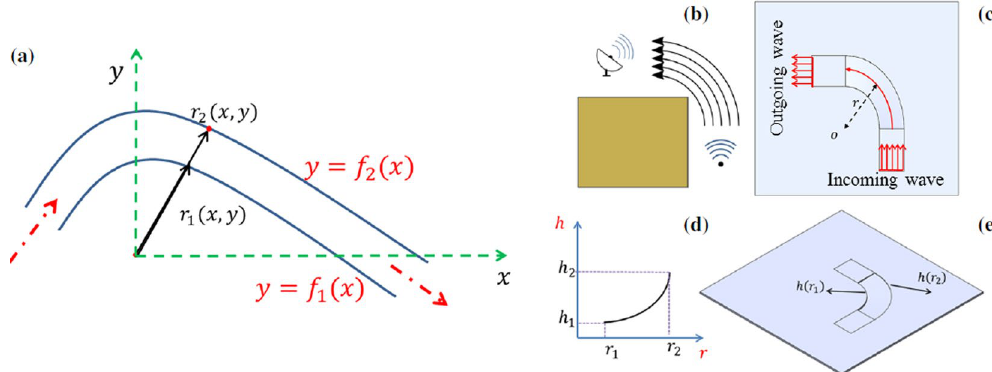
Figure 1. Overview of the proposed wave-bending approach. (a) Geometry associated with wave bending on a flat plate. (b) Schematic of the proposed structure to bend a flexural wave from a source to a receiver. (c) Top view of the structure serving as the host medium and the machined channel to bend the wave. (d) Thickness profile of the channel; and (e) Schematic of the thickness variation along the guiding